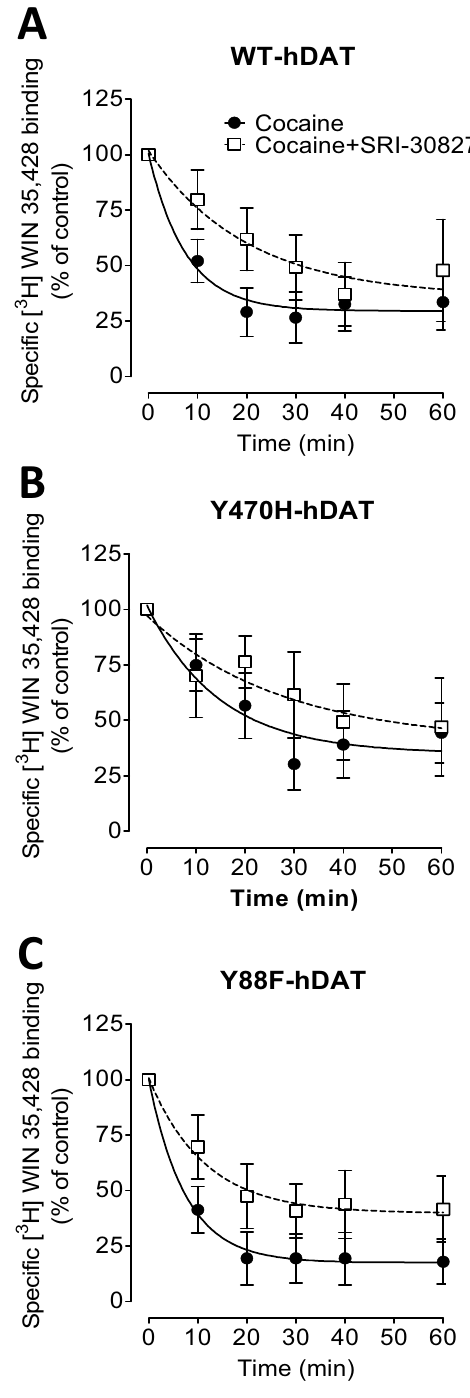
Figure 3. Effects of SRI-30827 and cocaine on the dissociation of [ 3 H]WIN 35,428 in WT hDAT and mutants. PC12 cells transfected with WT hDAT ( A ) or Y470H-hDAT ( B ), and Y88F-hDAT ( C ) were incubated with [ 3 H]WIN 35,428 (final concentration, 5 nM) on ice for 2 h. After the 2 h incubation, the incubation reagent was replaced with fresh assay buffer. At the zero time point, cocaine (1 µ M) was added to Condition-1 and Condition-2 (also see Table 5). Ten minutes later, SRI-30827 (50 nM) was added to Condition-2. Cells were lysed at indicated time points. For the data analysis, the 100% control point (no drug) was time 0 for Condition-1 and time 10 min point for Condition-2. Each data point is the mean ± S.E.M. ( n =